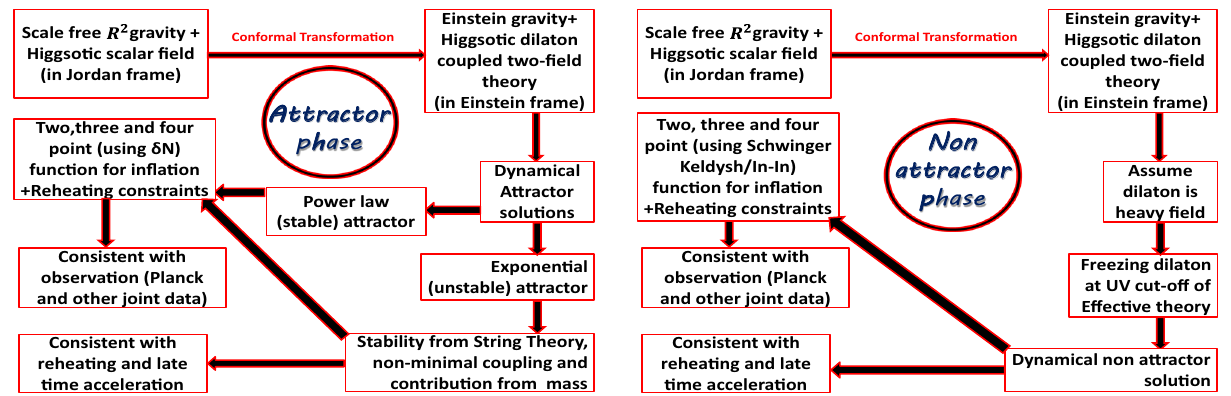
Diagrammatic representation of attractor phase of soft Higgsotic inflation. In this representative diagram we have shown the steps followed during the computation.